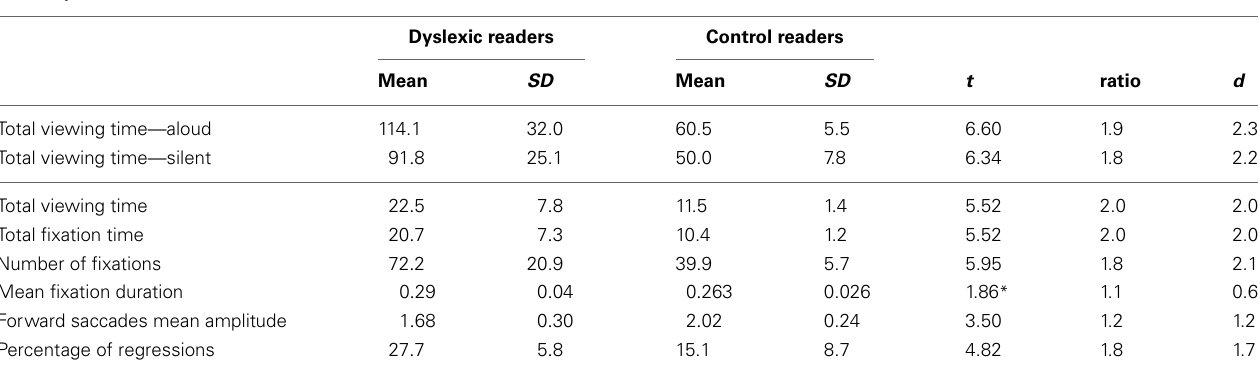
Table 4 | Group results for eye movement